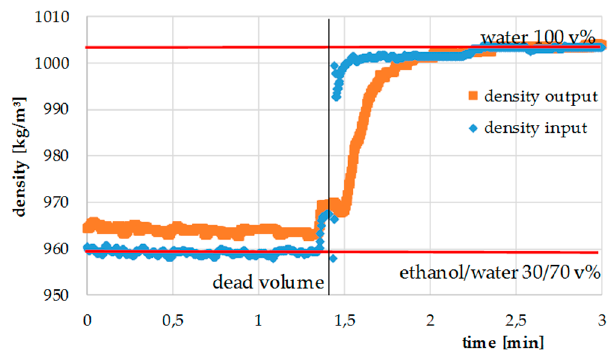
Figure 11. Determination of void volume by short-cut method.